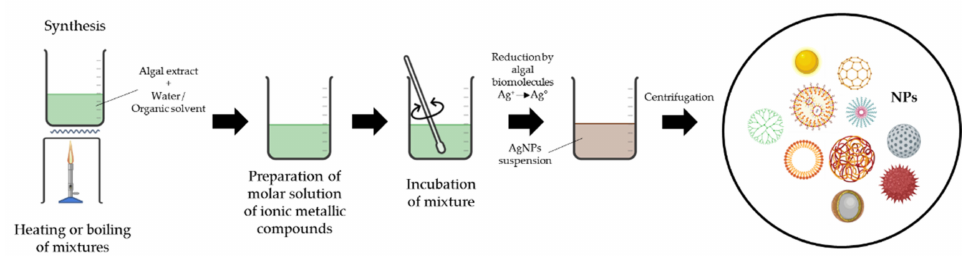
Figure 7. Overview of steps of synthesize mediated by algae extract (adapted from Vincy et al. [202]). Spirulina platensis is a blue-green alga, the major contributor of AgNPs. S. platensis is free floating, filamentous cyanobacteria that synthesized spherical AgNPs (2–8 nm)